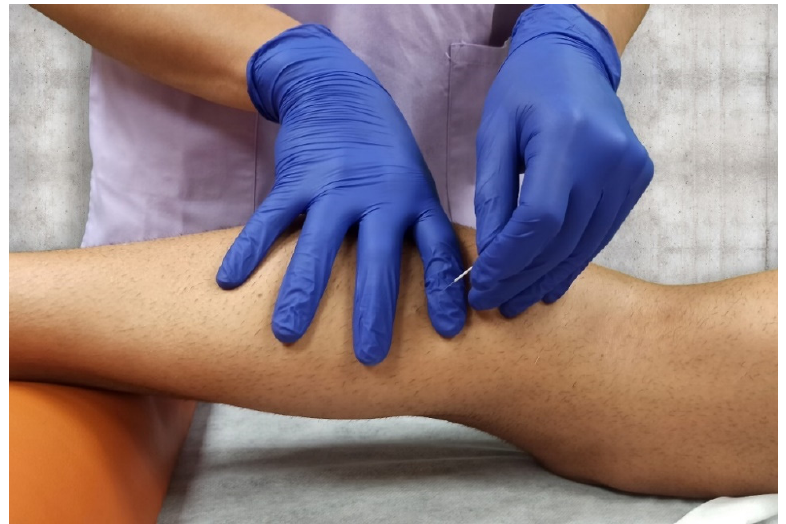
Figure 6. Dry needling procedure on gastrocnemius muscle with “fast-in and fast-out” techniques.